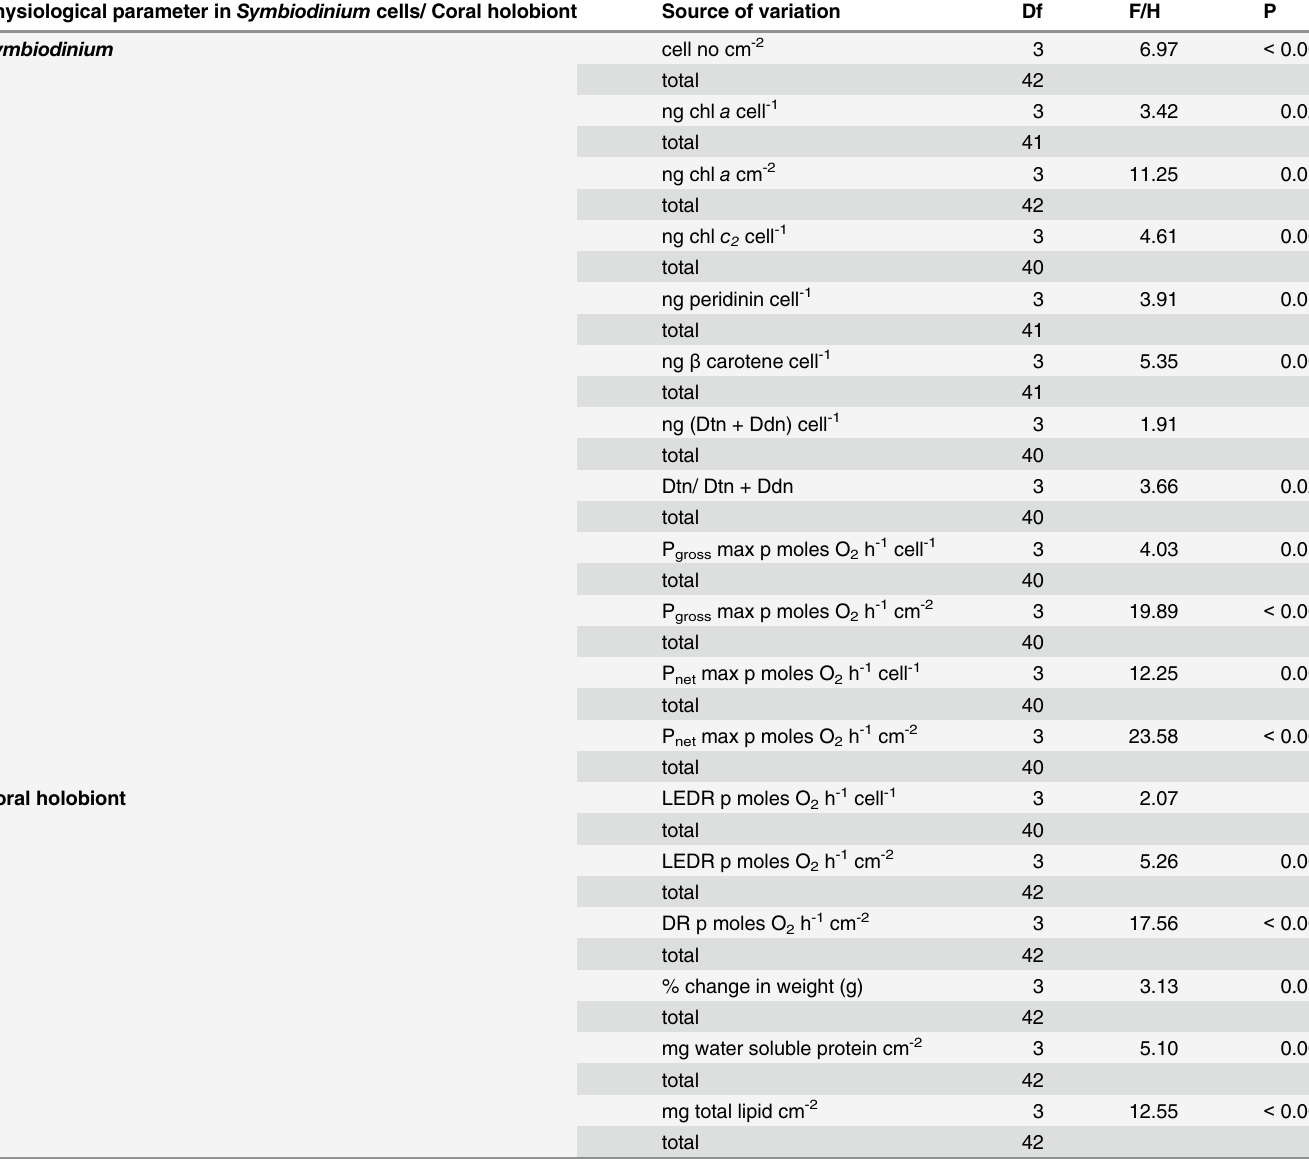
Table 2. Results of one way ANOVA/Kruskal Wallis test for physiological parameters. These Acropora millepora and Symbiodinium parameters are presented in Figs 1 and 2, for corals exposed to different temperature and pCO 2 scenarios (Pre-Industrial, Present Day, RCP4.5 and RCP8.5), where RCP stands for Representative Concentration